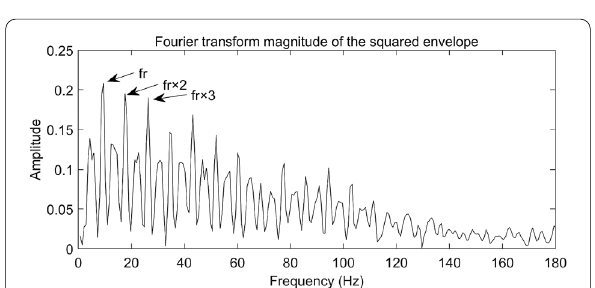
Figure 21 The squared envelope spectrum of the processed signal based on the maximum correlation coefficient